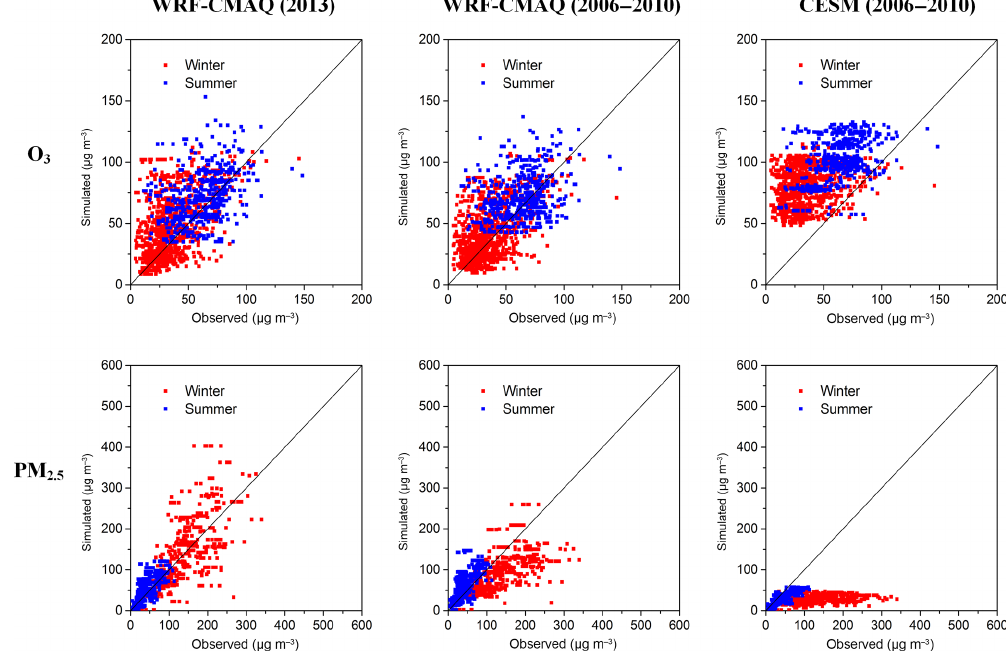
Figure 9. Scatter plots of simulated (by WRF-CMAQ – left and middle – and CESM – right) and observed PM 2 . 5 (bottom) and O 3 (top) in winter (red) and summer (blue). Each scatter represents the value at each observational site. The years of observational data, WRF-CMAQ (2013), WRF-CMAQ (2006–2010), and CESM simulations were 2013, 2013, 2006–2010, and 2006–2010, respectively. Note that for O 3 observed data in winter, observational data in 2014 were used because of some errors in the data in